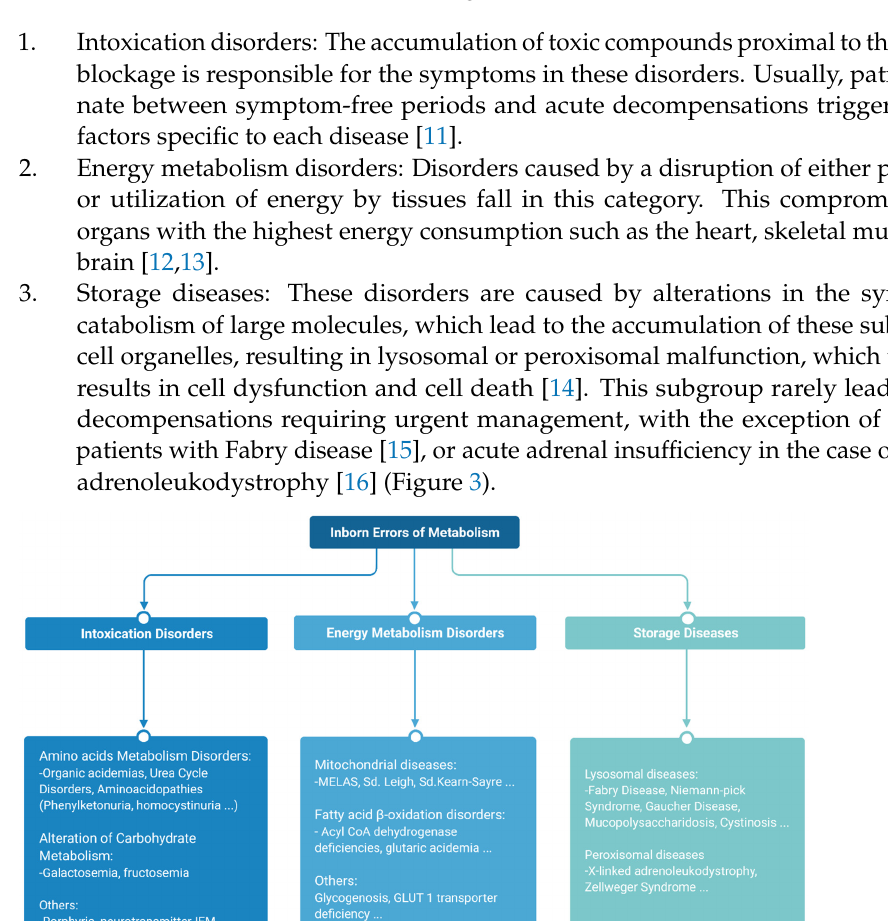
Figure 2. Inborn errors of metabolism nosological classification.